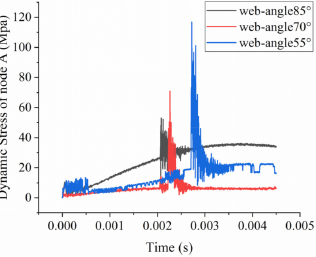
Figure 11. Dynamic stresses of models with different web support